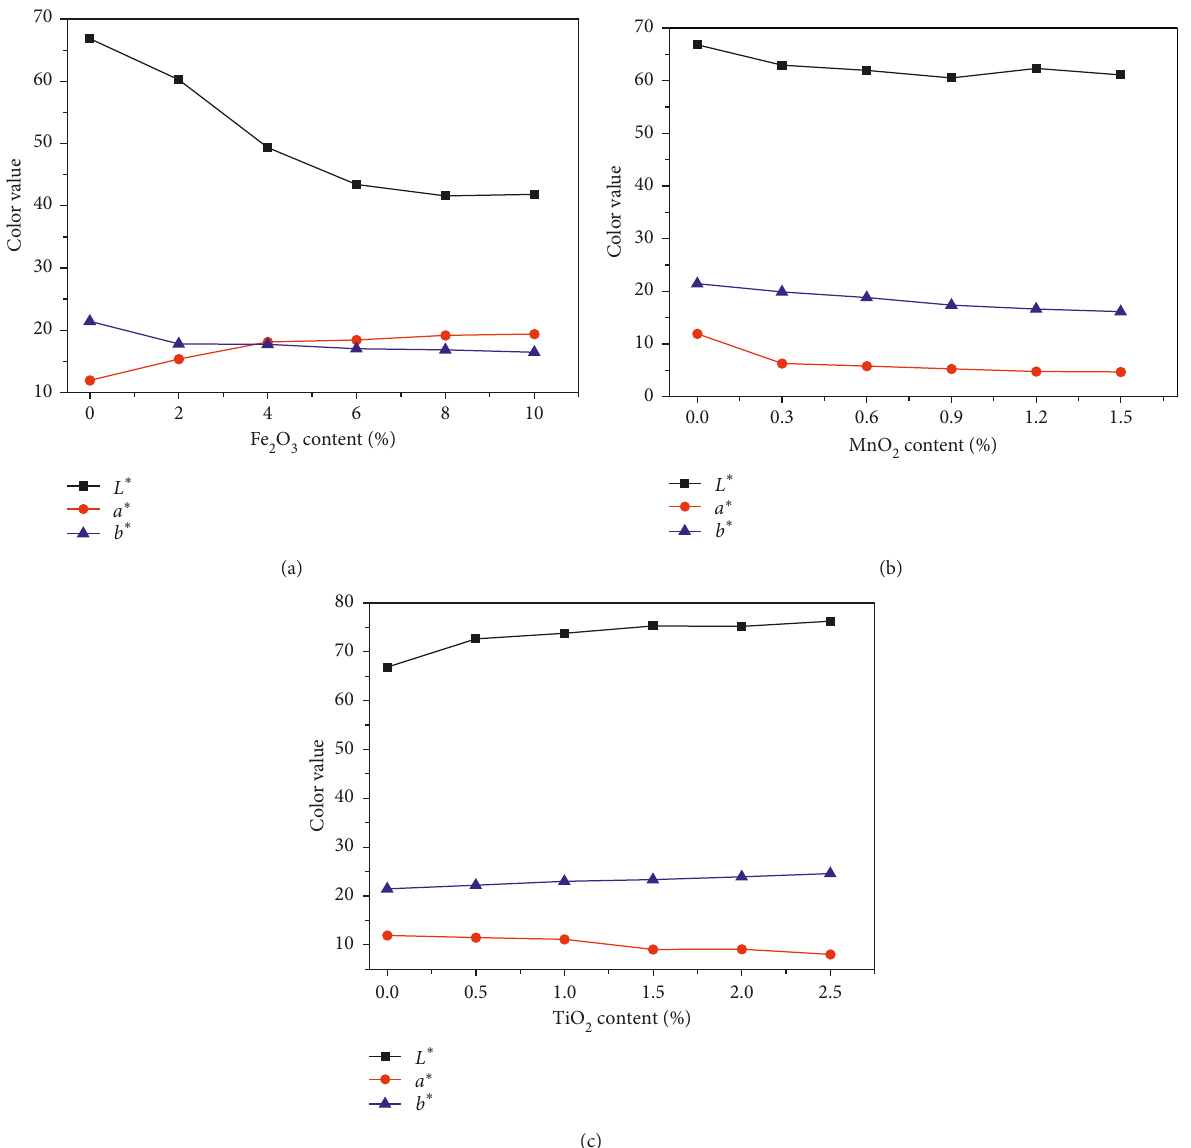
Figure 2: Effect of different colorants on the color of ceramics: (a) Fe